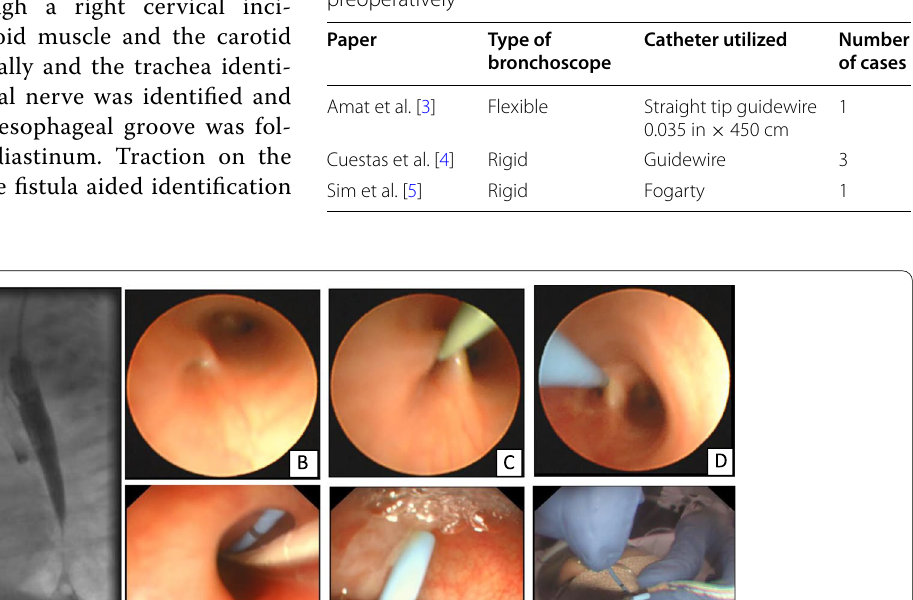
Table 1 Other modalities used to cannulate H-type